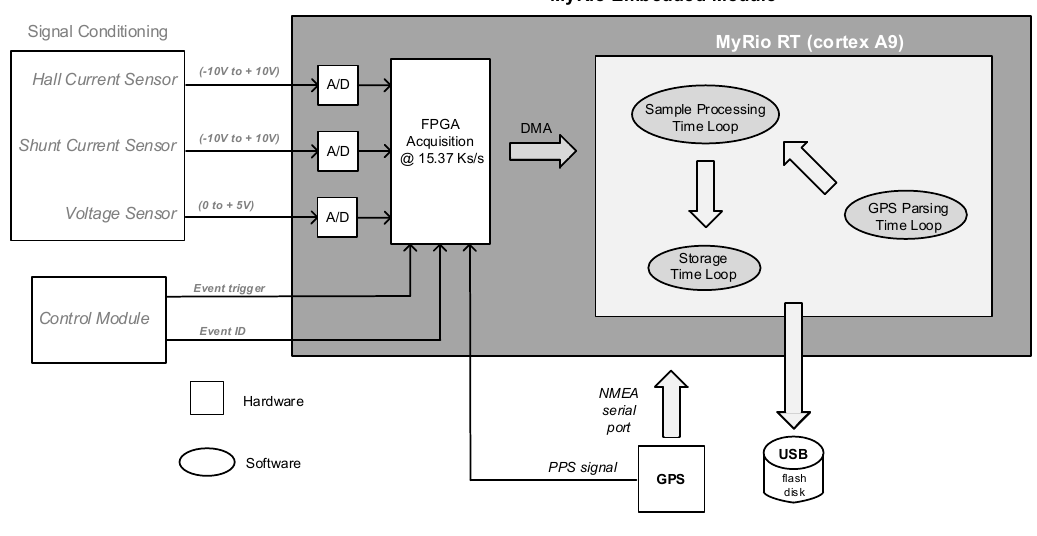
Figure 3. Block diagram of data acquisition using the MyRio device. Adapted from